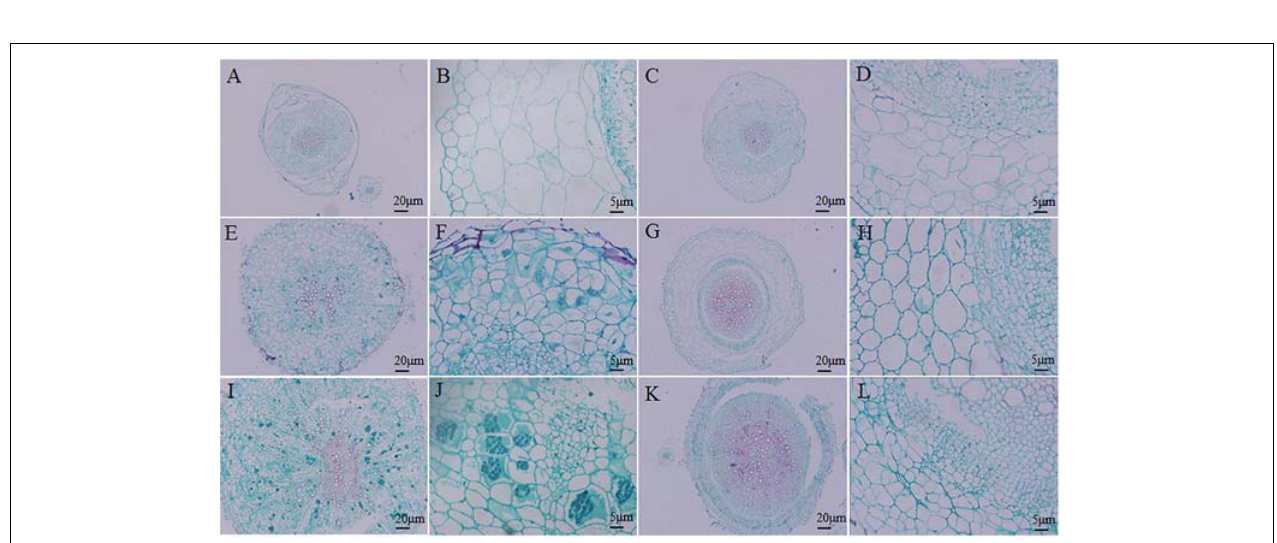
FIGURE 3 | Histocytological analysis of cross-sections of inoculated resistant and susceptible plants. (A,B,E,F,I,J) Sections of root of Brassica napus . (C,D,G,H,K,L) Sections of root of Matthiola incana. (A–D) Sections of inoculated roots at 14 days after inoculation (DAI). (E–H) Sections of inoculated roots at 20 DAI. (I–L) Sections of inoculated roots at 28 DAI. Adjustments for magnification and illumination were performed to allow optimal viewing of the individual sections.